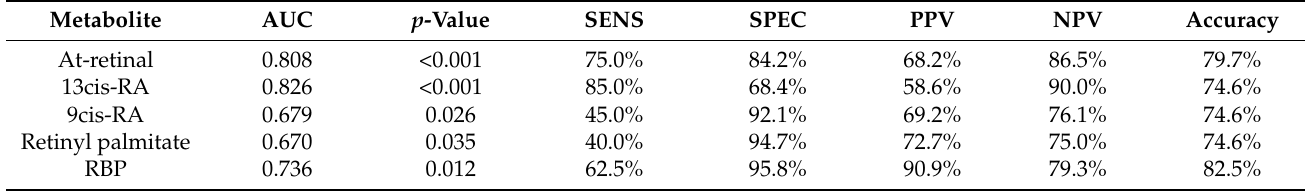
Table 3. Efficacy of retinol-related metabolites for predicting preterm birth.